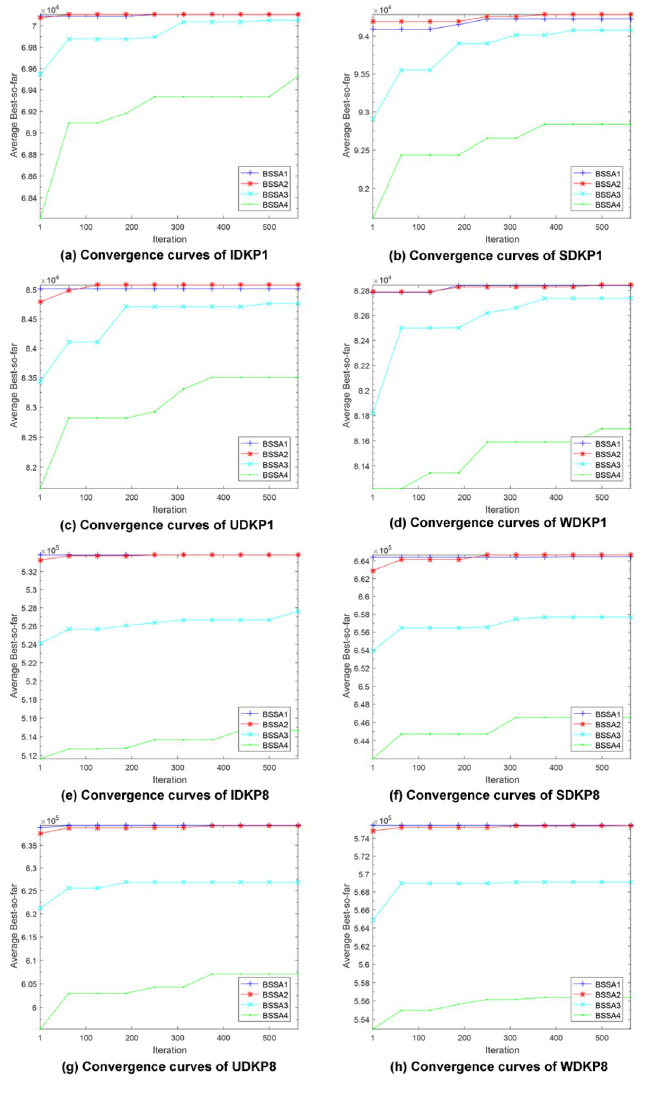
Fig 3. Convergence